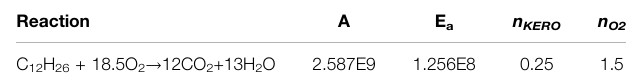
TABLE 2 | Boundary conditions of internal fl ow fi eld.